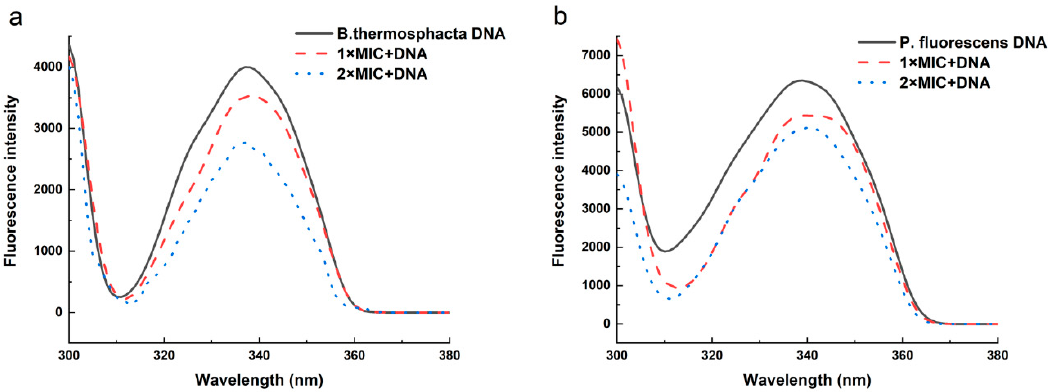
Figure 9. Fluorescence spectra of ( a ) B. thermosphacta and ( b ) P. fluorescens genomic DNA in the presence of increasing amounts of 3-carene. Fluorescence spectra were measured from 300 to 500 nm (k ex = 280 nm).